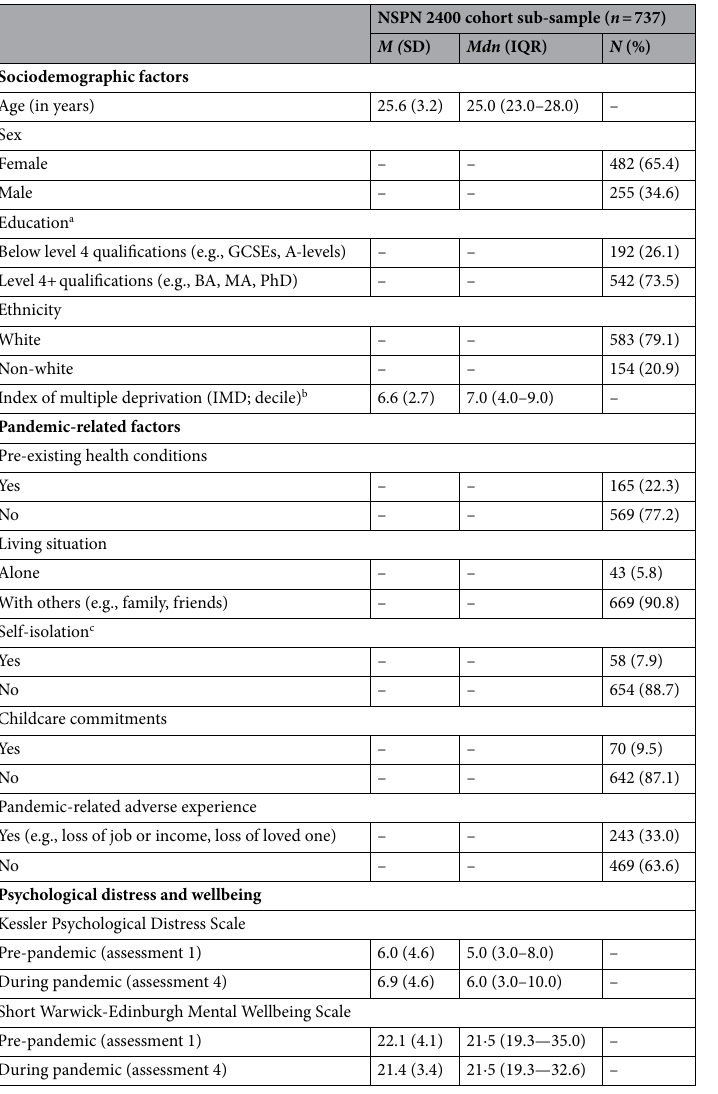
Table 1. Sample characteristics including sociodemographics, pandemic-related factors as well as pre- and mid-pandemic psychological distress and wellbeing for NSPN 2400 cohort participants who took part in all four assessments including the most recent follow-up in May 2020. a Qualification levels were assessed as in the census for England & Wales (2011) where Level 4 and above includes at least at least a first degree (or equivalent) and, at most, a doctoral degree such as a PhD. b Index of Multiple Deprivation (IMD) was assessed based on the English Indices of Deprivation (2015) whereas the lowest decile refers to the most deprived 10% of areas in England. c Self-isolation was defined as present for anyone not leaving the house for at least 7 days. Missing data: education ( n = 3), IMD ( n = 10), pre-existing health conditions ( n = 3), living situation ( n = 25), self-isolation ( n = 25), childcare commitments ( n = 25), pandemic-related adverse experience ( n = 25), Kessler Psychological Distress Scale (K6; n = 6 for pre-pandemic, n = 13 for during pandemic), Short Warwick- Edinburgh Mental Wellbeing Scale (SWMEBWS; n = 10 for pre-pandemic, n = 26 for during